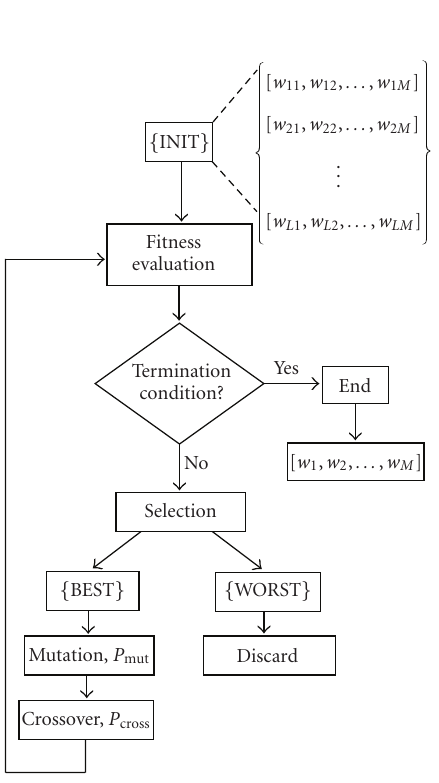
Figure 6: Flowchart of the proposed GA.